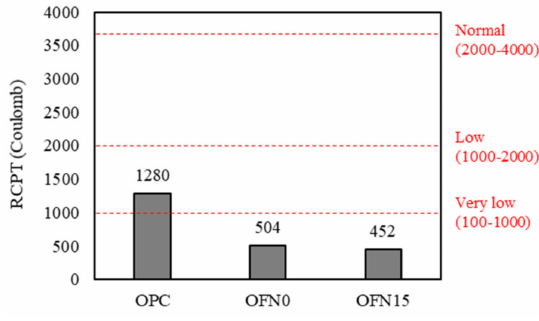
Figure 6. Chloride penetration resistance of